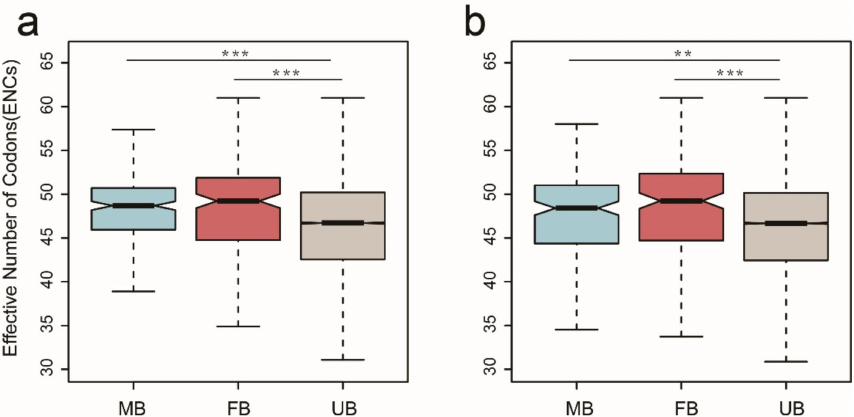
Figure 5. Codon bias of sex-biased and unbiased genes in the cerebrum ( a ) and syrinx ( b ). Male- biased genes (MB); female-biased genes (FB); and unbiased genes (UB). Significant difference is represented by *, using Wilcoxon rank sum test, * p < 0.05, ** p < 0.01, *** p <